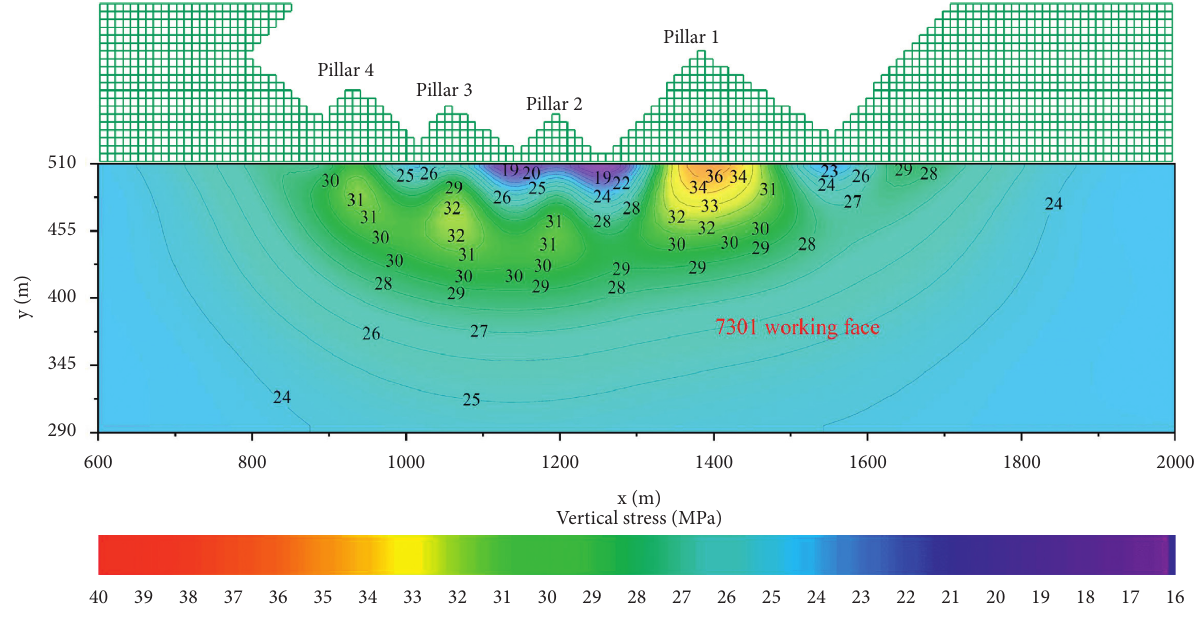
Figure 5: The vertical stress distribution of working face with influence of